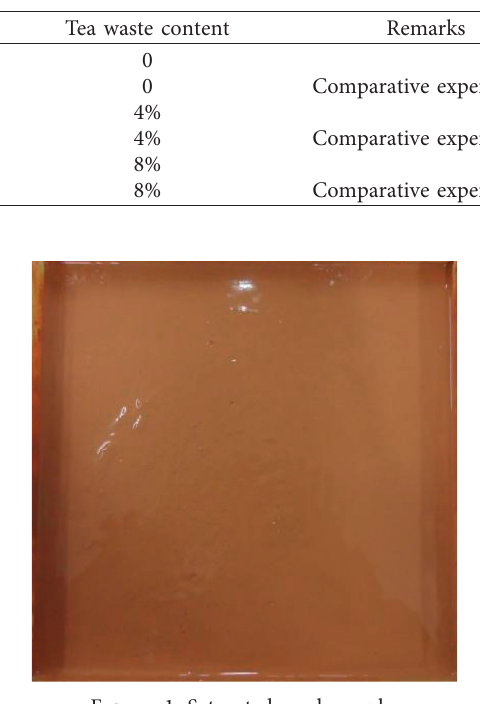
Table 2: Design parameters of evaporation test.